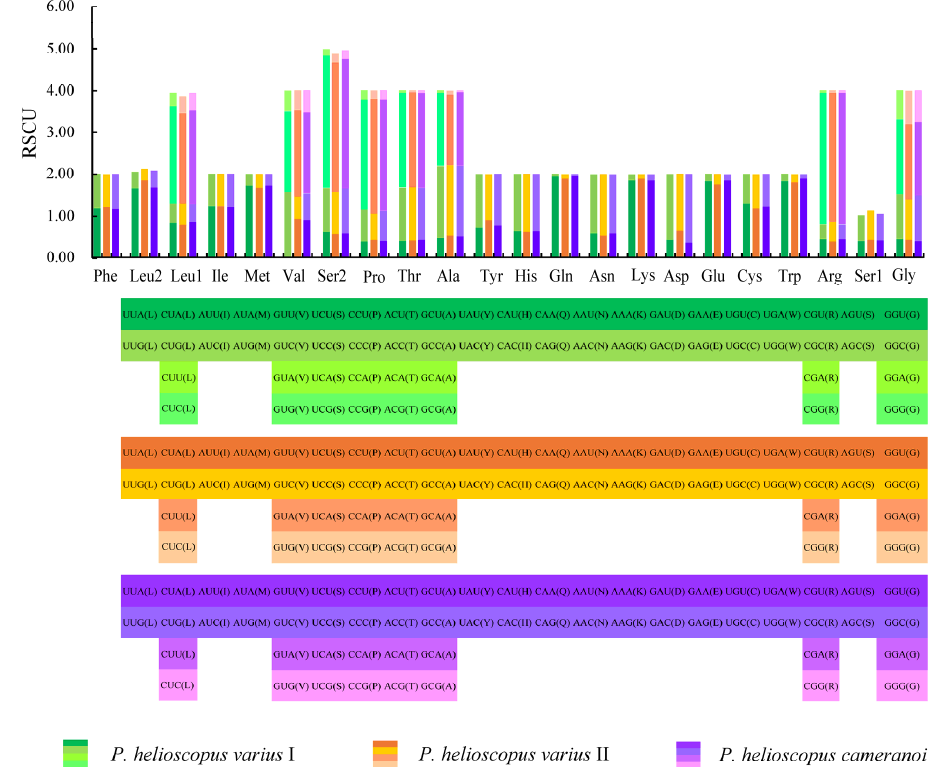
Figure 4. The relative synonymous codon usage (RSCU) in the mitogenomes of P. helioscopus varius I, P. helioscopus varius II, and P. helioscopus cameranoi . The codons are shown on the X -axis and the RSCU values are shown on the Y -axis.